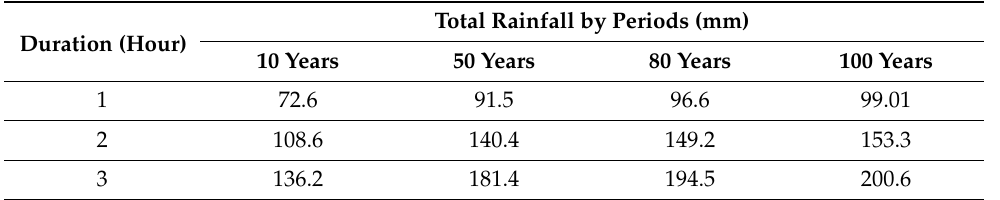
Table 1. 1, 2, and 3-h total rainfall during different return